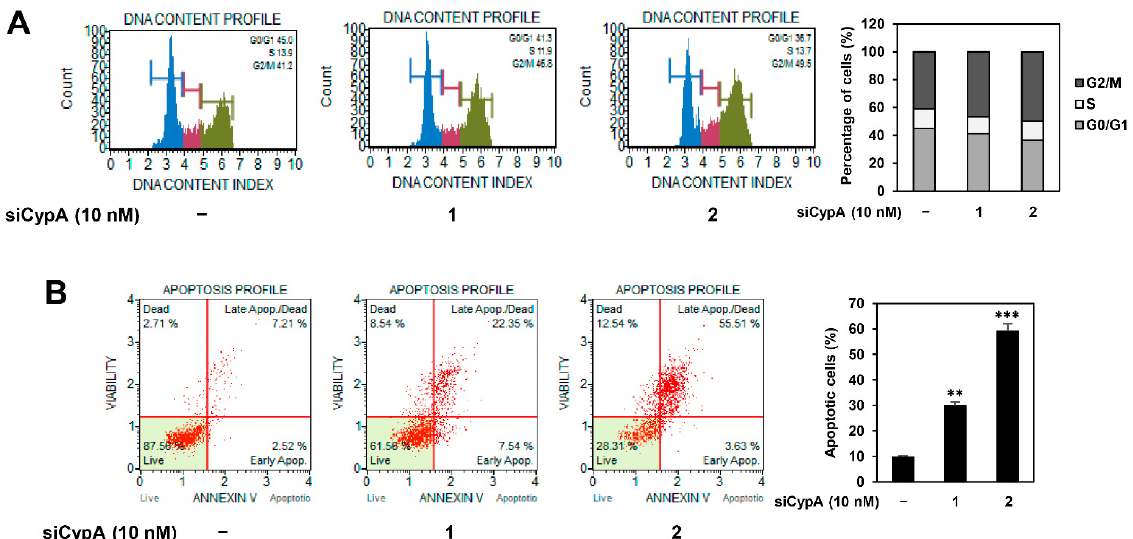
Figure 6. Effect of CypA knockdown on the cell cycle progression and apoptosis of AGS cells. AGS cells were transfected with CypA siRNAs (10 nM) and incubated for 72 h. ( A ) The cell cycle distribution and ( B ) apoptotic cell death were analyzed using a Muse cell analyzer and Muse analysis software. ** p < 0.01, *** p < 0.001 vs. the control.